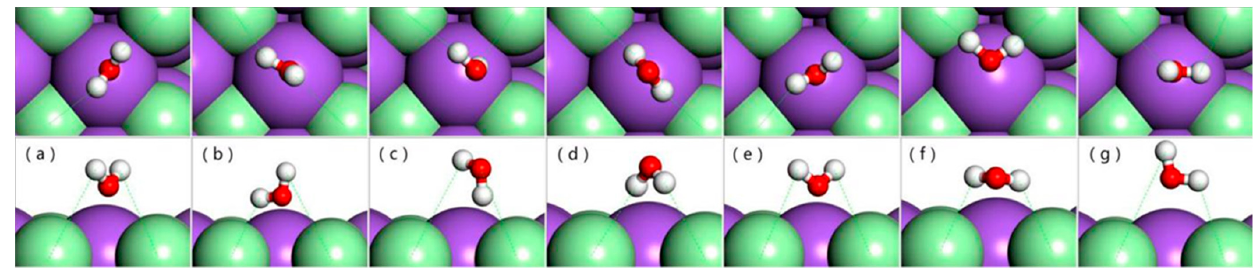
Figure 1. Seven conformations from ( a – g ) of a water monomer on an NaCl(001) surface. The upper picture is the top view and the lower picture is the side view for each optimized model. Conformation f has the lowest system energy. O, H, Cl − , and Na + are denoted by red, white, green, and purple spheres, respectively. Table 1. Energy difference (E) and optimized structural parameters of the seven models. The low- est system energy of conformation f was taken as the reference point. The two nearest H–Cl dis- tances are presented for comparison.